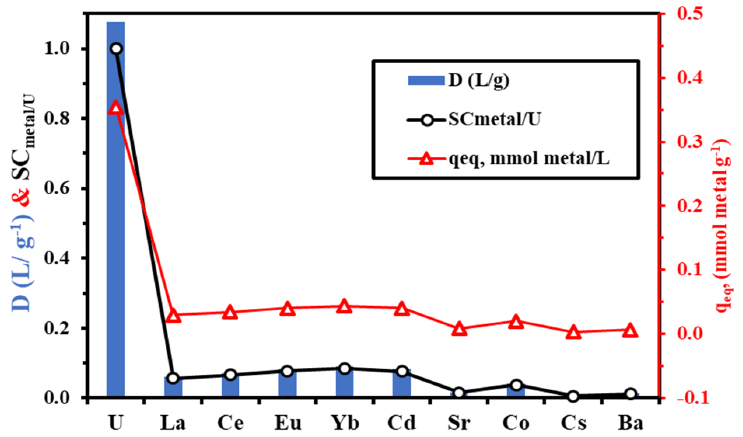
Figure 6. Sorption capacities, distribution coefficients, and selectivity coefficient (SC metal/U ) in selec- tivity tests (SD: 0.5 g/L, C 0 : 0.5 mmol/L, pH 0 : 4.0, T: 298 ± 1 K, Time: 180 min, 200 rpm).